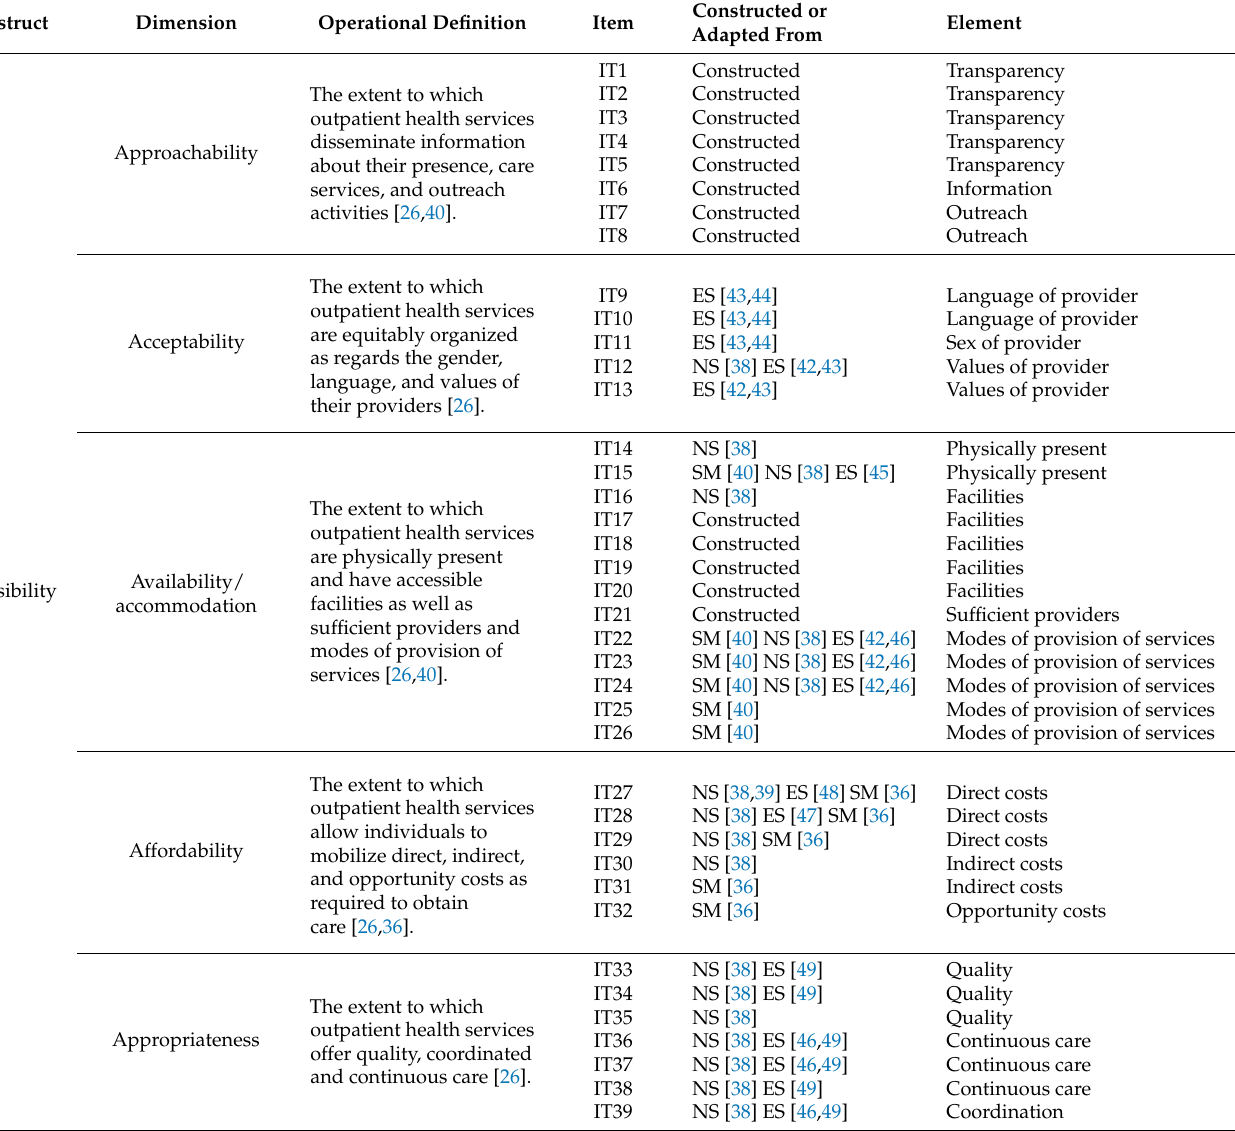
Table 1. List of items included in the scale according to the five dimensions of the accessibility construct ( n =